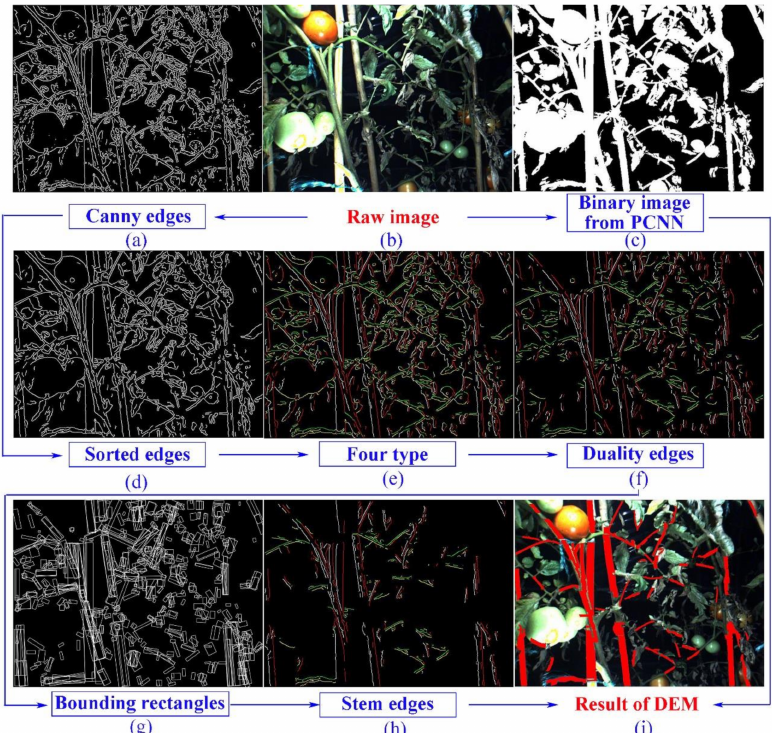
Figure 3. Flowchart of the method based on duality relation in edge pairs (DEM): ( a ) raw image; ( b ) binary image; ( c ) Canny edges; ( d ) sorted edges; ( e ) four type edges; ( f ) duality edges; ( g ) bounding rectangles; ( h ) stem edges; ( i ) result of the DEM. Red captions refer to the input and output images, and blue captions refer to images in